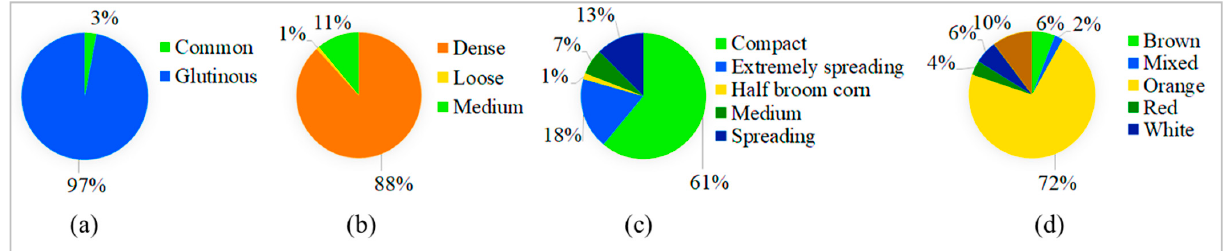
Figure 1. Frequency (%) of endosperm type ( a ), panicle density ( b ), panicle type ( c ) and seed color ( d ) in sorghum landraces.